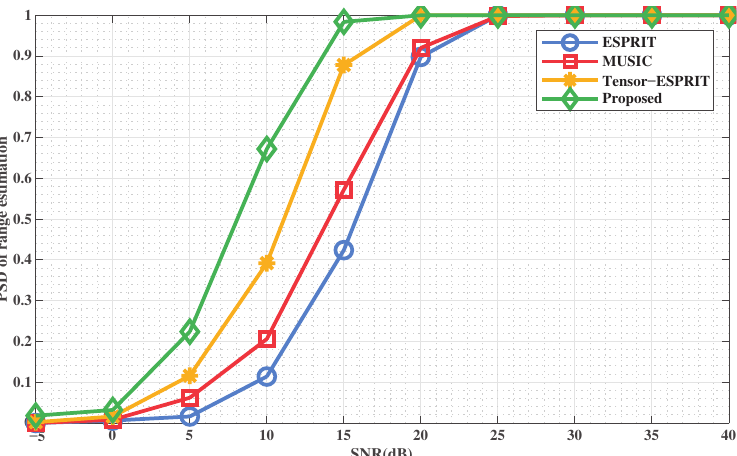
Figure 10. PSD of range estimation versus